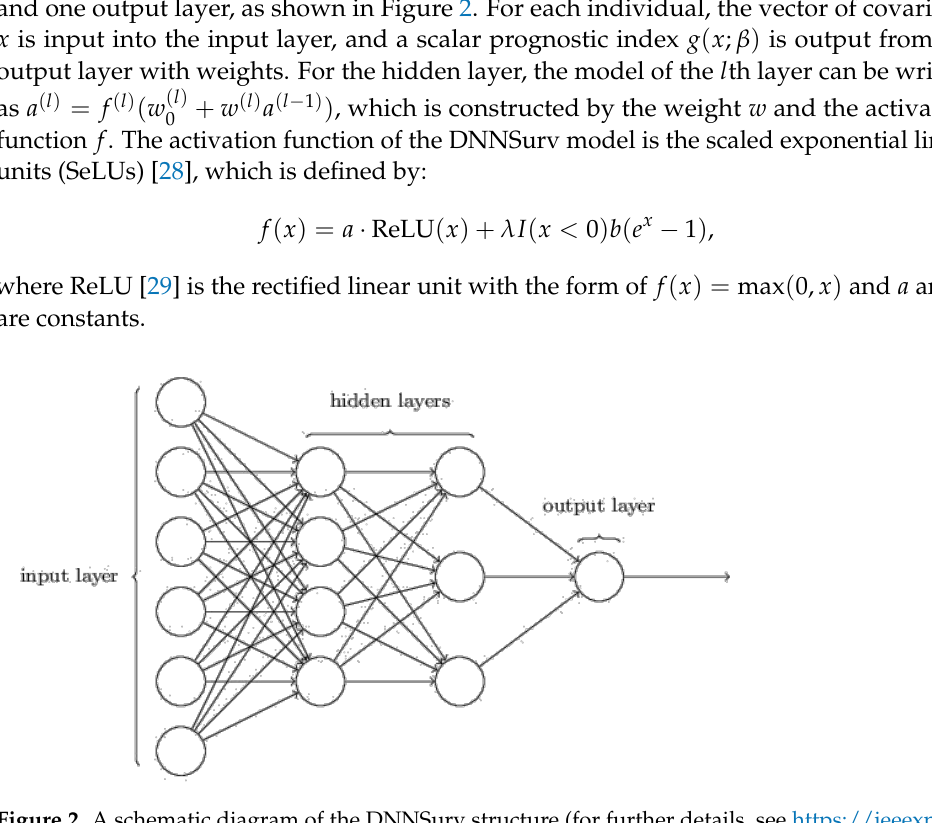
Figure 2. A schematic diagram of the DNNSurv structure (for further details, see https://ieeexplore. ieee.org/document/8737773) (accessed on 1 April